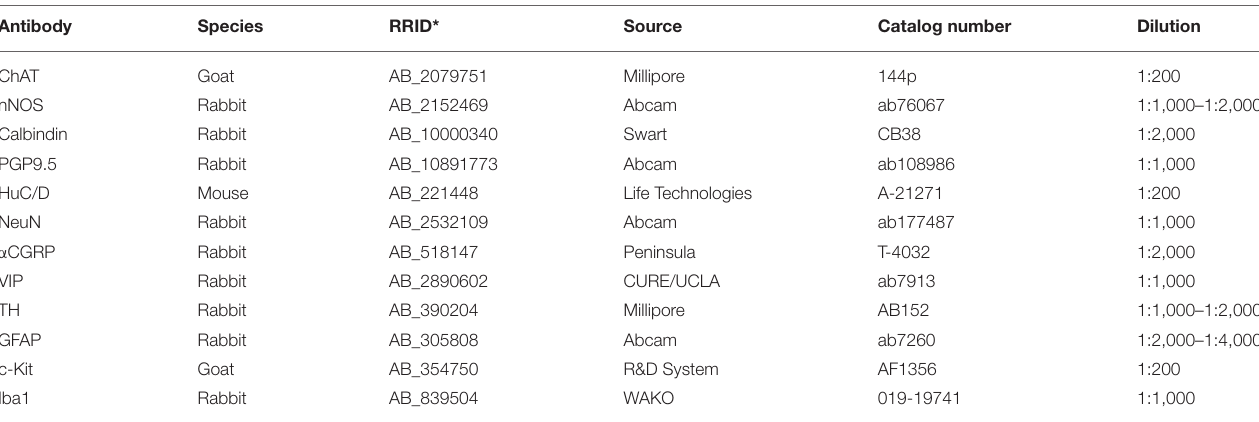
TABLE 2 | Primary antibodies. Antibody Species RRID* Source Catalog